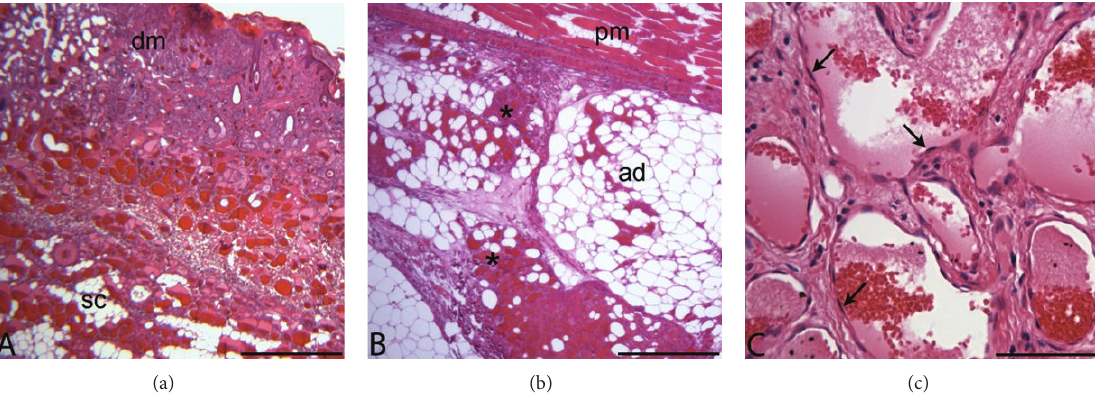
Figure 2: (a) Photomicrograph, goat, cutaneous mass. Subgross image of biopsied skin and panniculus tissue demonstrates neoplastic endothelial cells lining vascular channels in the dermis (dm) and subcutis (sc). H&E stain; bar = 250 𝜇 m. (b) Photomicrograph, goat, cutaneous mass. High power image of biopsied tissue. Neoplastic endothelial cells (asterisks) are present deep to the panniculus muscle (pm) and infiltrating amongst lightly encapsulated lobules of mature adipose tissue (ad). H&E stain; bar = 250 𝜇 m. (c) Photomicrograph, goat, cutaneous mass. Neoplastic endothelial cells (arrows) are flattened with minimal atypical features. H&E stain; bar = 100 𝜇